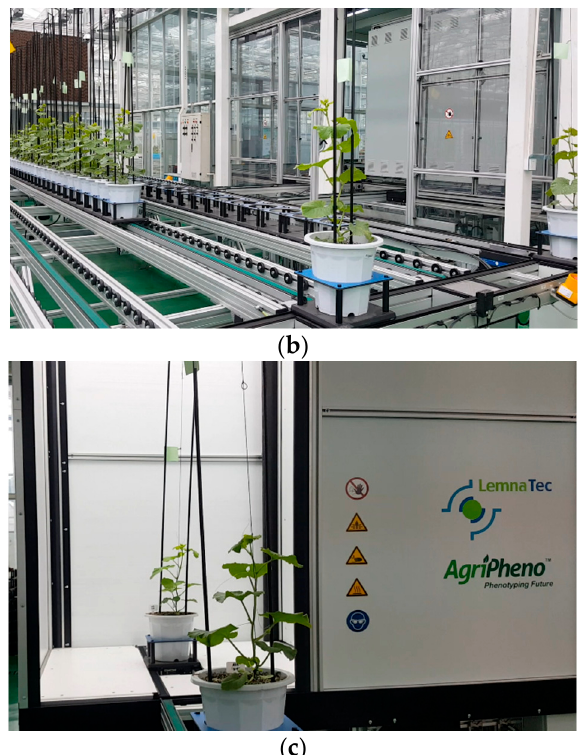
Figure 2. ( a ) Test site of plant cultivation, ( b ) automatic plant conveyors system, ( c ) Lemnatec 3D phenotyping system.